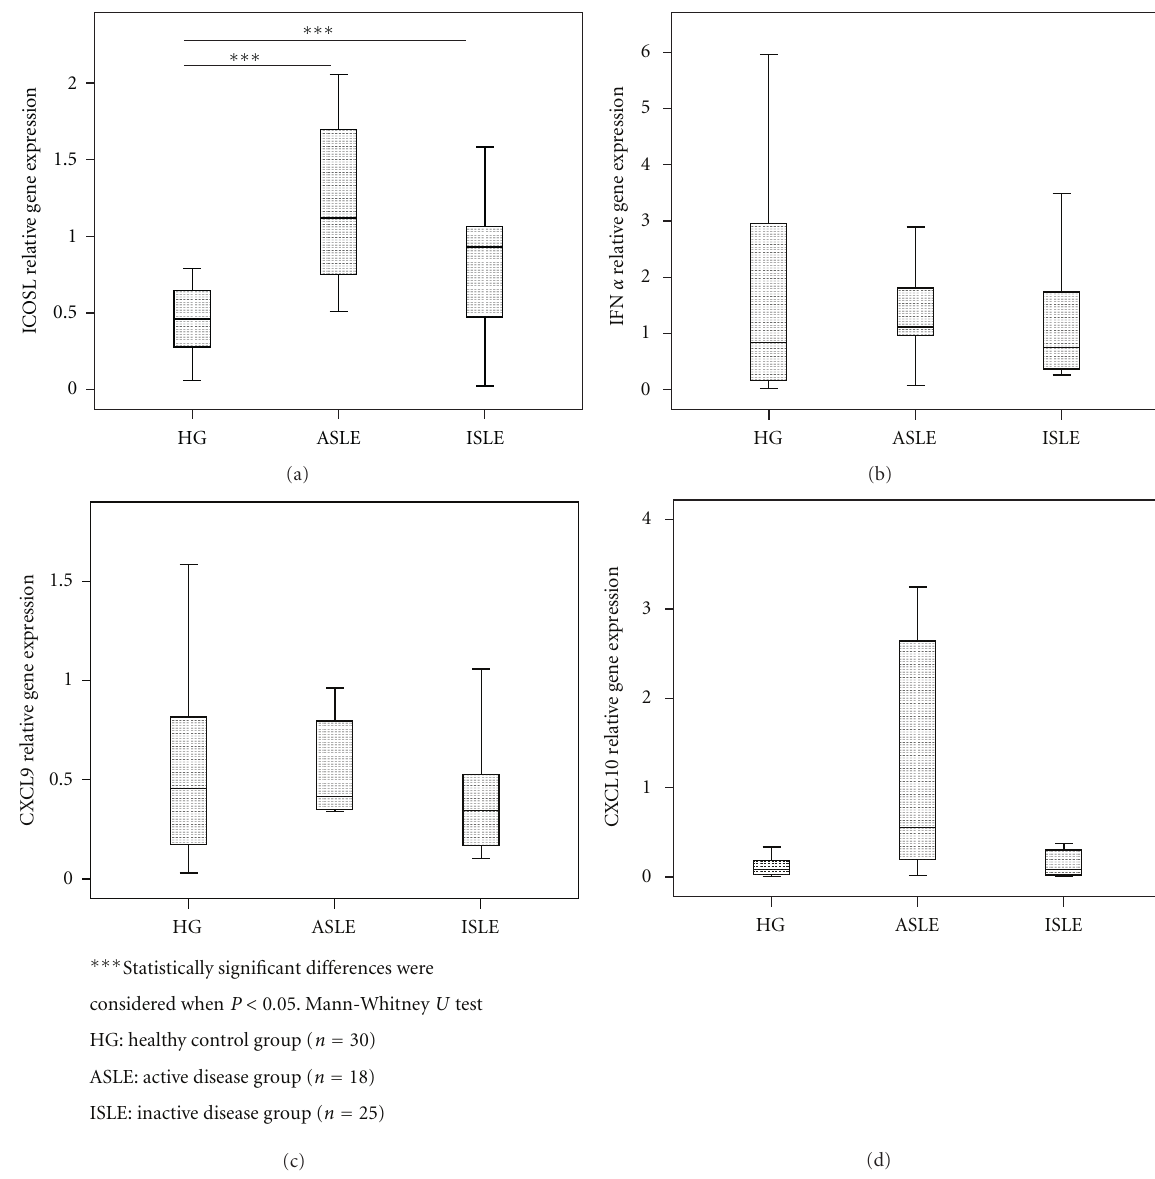
Figure 4: ICOSL, IFN- α , CXCL9, and CXCL10 relative gene expression in cell-sorted mDCs subset in the three studied groups (HG, ASLE, and